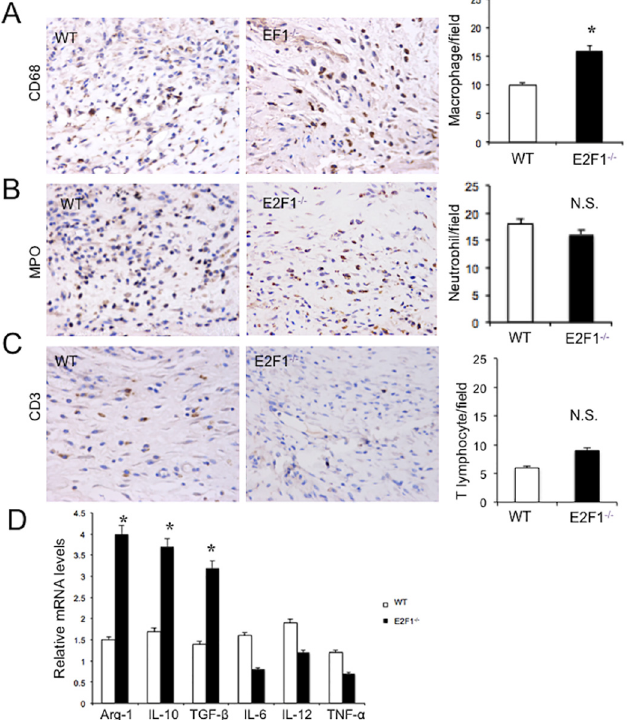
Fig 4. More infiltrating macrophages are found in the wound of E2F1 – / – mice than in WT mice. At day 7 post-surgery, the wound skin tissues were analyzed immunochemically and by qRT-PCR. Shown are representative staining ( left and middle panels ) (original magnification, X400; 0.06 mm 2 /field) and quantifications ( right panels ) of the cells stained positive for CD68 (A), MPO (B) and CD3 (C). (D) The expression levels of M1 and M2 macrophage marker genes in the wounded skin tissues of WT and E2F1 – / – mice were analyzed by qRT-PCR. ** p < 0.01. n.s., not significant; n = 10 per